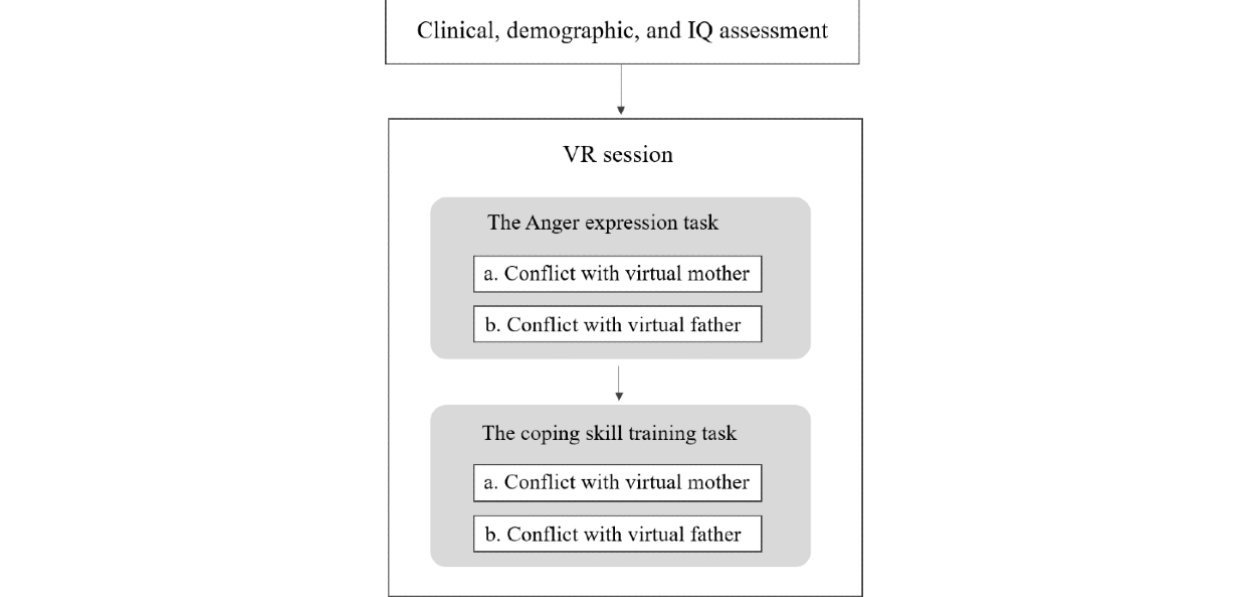
Figure 1. Experimental procedure. The order of tasks on conflicts with the virtual mother and father was counterbalanced. VR: virtual reality.